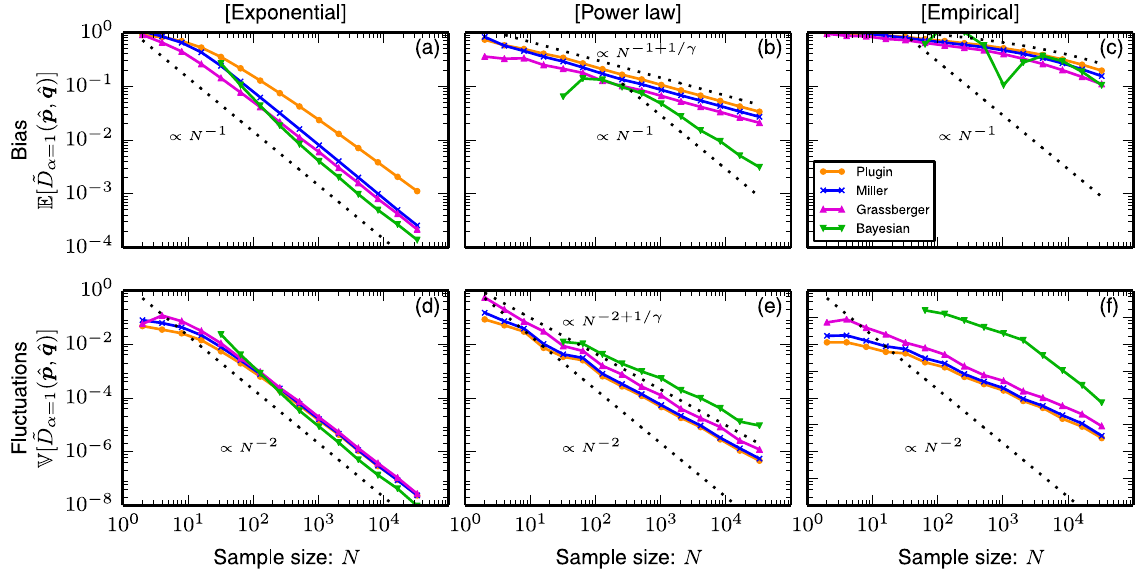
~ D ~ D – (c) Estimation of E ½ ~ D ð ˆ p ; ˆ q Þ(cid:3) between two FIG. 4. Finite-size estimation of the normalized Jensen-Shannon divergence ¼ α ¼ 1 . (a) sequences of size N drawn from the same distribution [i.e., D ð p ; q Þ ¼ 0 ] using four different estimators of the entropy (see text) for three representative distributions: (a) Exponential (short-tailed) distribution p i ∝ e − ai for i ¼ 0 ; 1 ; … with a ¼ 0 . 1 , (b) power-law (heavy- tailed) distribution p i ∝ i − γ for i ¼ 1 ; 2 ; … with γ ¼ 3 = 2 , and (c) empirical Zipf distribution of word frequencies, i.e., rank-frequency distribution p ð r Þ from the complete Google-ngram data, p i ¼ f ð i ¼ r Þ for i ¼ 1 ; … ; 4623568 , which is well described by a double ~ D power law [11]. (d) – (f) The same as (a) – (c) for the fluctuations V ½ ð ˆ p ; ˆ q Þ(cid:3) . The dotted lines show the expected scalings from Table II for short-tailed distributions, i.e., N − 1 ( N − 2 ), and power-law distributions, i.e., N − 1 þ 1 = γ ( N − 2 þ 1 = γ ), for the bias (fluctuations). In (c), we N Þ =N , where V N Þ is the expected number of different symbols in a random sample of show the expected scaling for the bias, V emp ð emp ð size N from the empirical distribution [32]. Averages are taken over 1000 realizations.